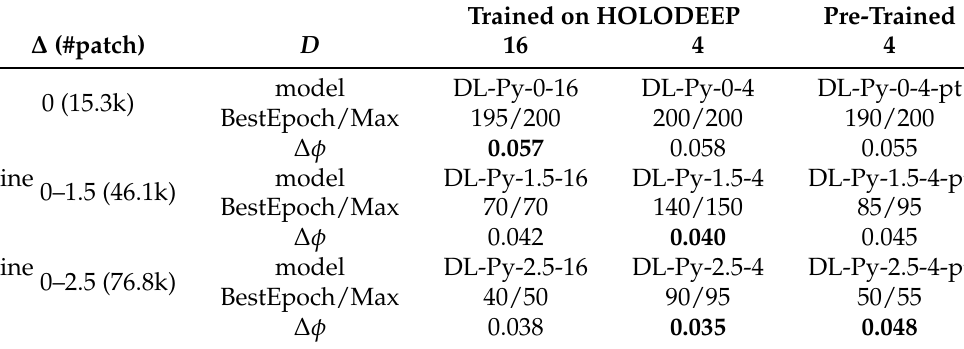
Figure 4. Python code with tensorflow framework (as tf), which defines the model architecture. Table 3. Phase errors ( ∆ φ in rad), obtained with one iteration on HOLODEEP. The best configurations are presented in bold font. Three training sets are used, each corresponding to a larger diversity of noise, and the number of patches used to train the model in each case is given. The model names are given for each configuration. The best epoch is given relative to the total number of epochs used to train the